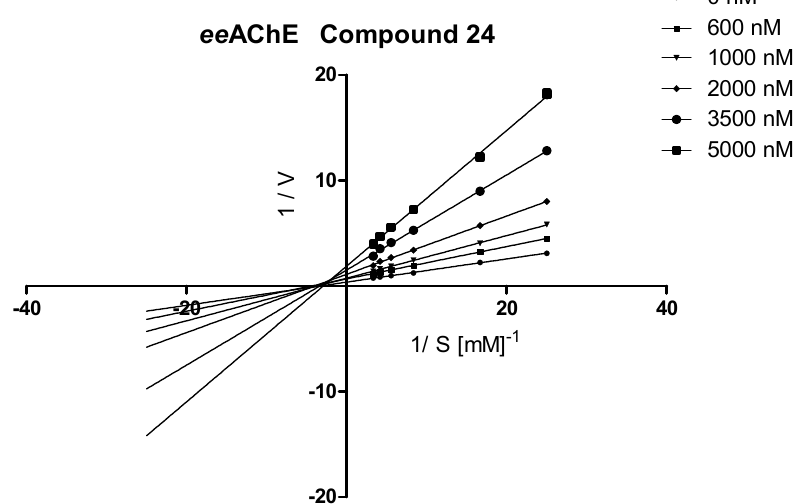
Figure 2. Lineweaver–Burk plot illustrating a noncompetitive type of ee AChE inhibition by compound 24 . S = acetylthiocholine; V = initial velocity rate.